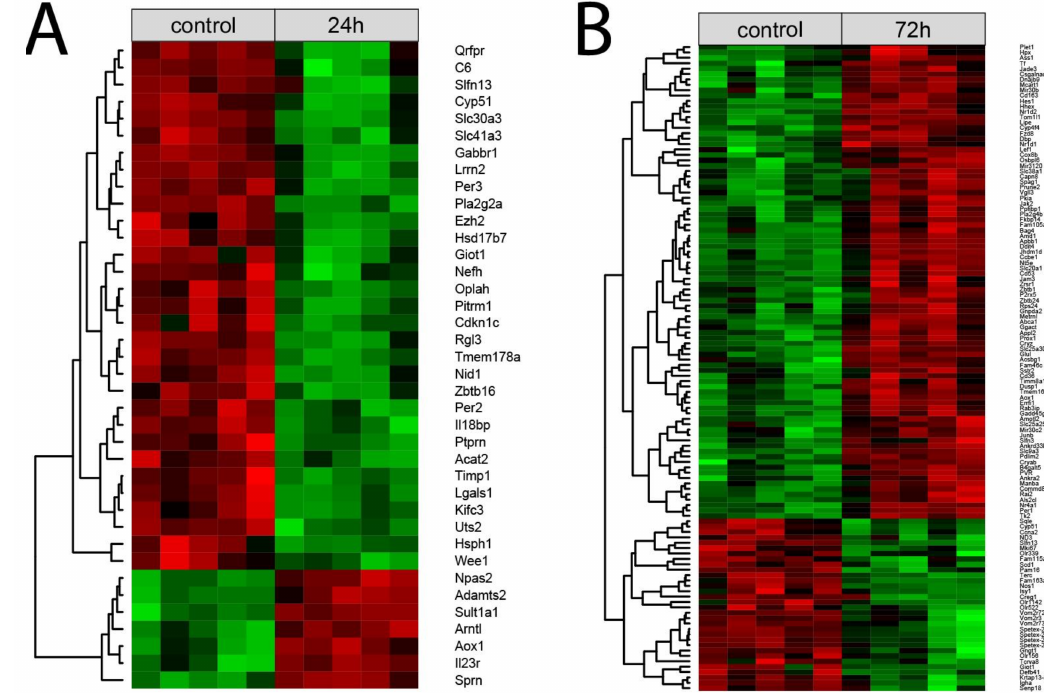
Figure 4. Heatmap with hierarchical clusterization of the differentially expressed genes in the right adrenals collected 24 h ( A ) or 72 h ( B ) after left adrenalectomy in relation to the right adrenals from sham-operated rats. Normalized signal intensity acquired from the microarray analysis is represented by color (green = higher expression; red = lower expression). Log2 signal intensity values for any single gene were resized to row Z-score